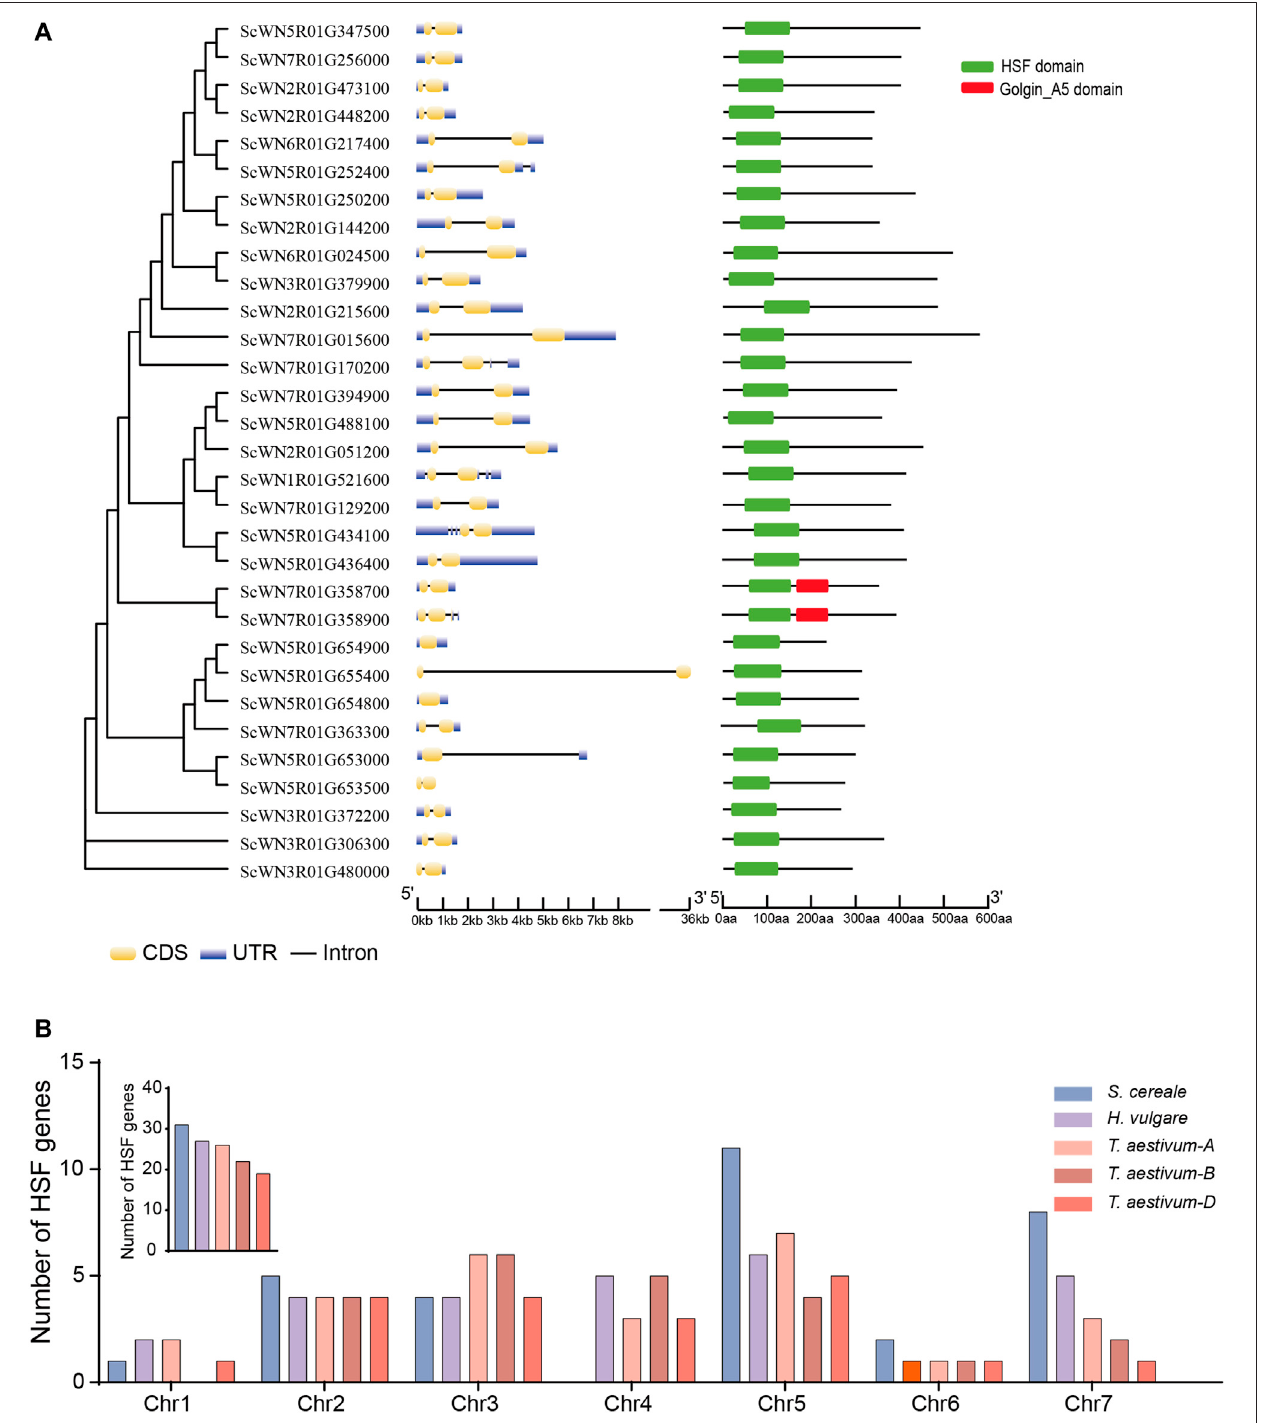
FIGURE1| Genestructure,domaincompositionandchromosomedistributionof S.cereale HSFgenes. (A) .HSFgenesinthe S.cereale genomewereorderedby the phylogeny. Genestructure and domain composition for each gene were shown following the gene name. (B) . The number of HSF genes on each chromosome in S. cereale were shown and compared to those of T. aestivum and H. vulgare .